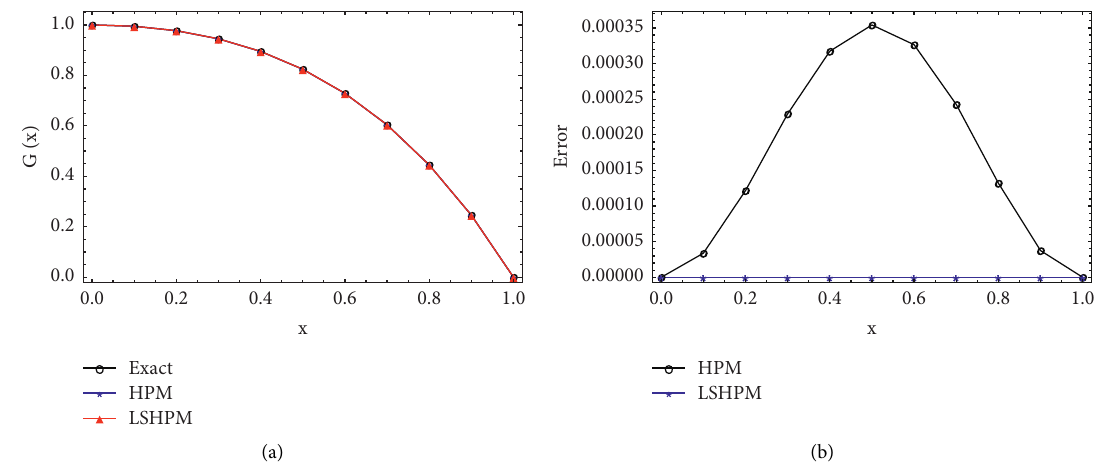
Figure 5: Graphical representation of solutions and errors in Problem 5. (a) Comparison of Exact, HPM, and LSHPM solutions. (b) Comparison of absolute errors of HPM and LSHPM.